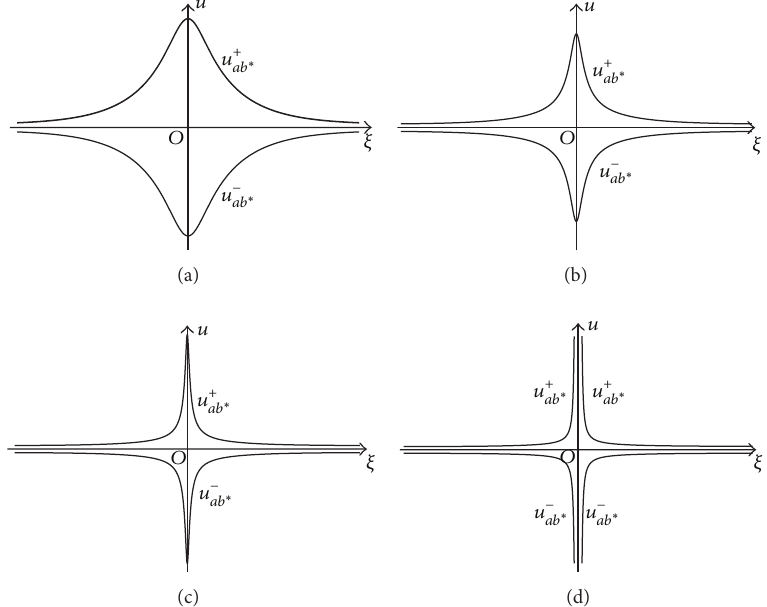
Figure 7: Two 1-blow-up waves are bifurcated from two symmetric solitary waves. The varying process for the figures of 𝑢 ± 𝑎𝑏 ∗ when 𝜆 = −√𝛽 2 − 4𝛼 (𝑎,𝑏) ∈ 𝐴 𝑏 → 0 + 0 , where 𝜆 = 𝑎 = −1 , 𝛾 = 𝛿 = 𝑐 = 1 , and (a) 𝑏 = 0 + 5 × 10 −1 , (b) 𝑏 = 0 + 10 −2 , (c) 𝑏 = 0 + 10 −4 , and 1 , 6 , and 1 (d) 𝑏 = 0 + 10 −7